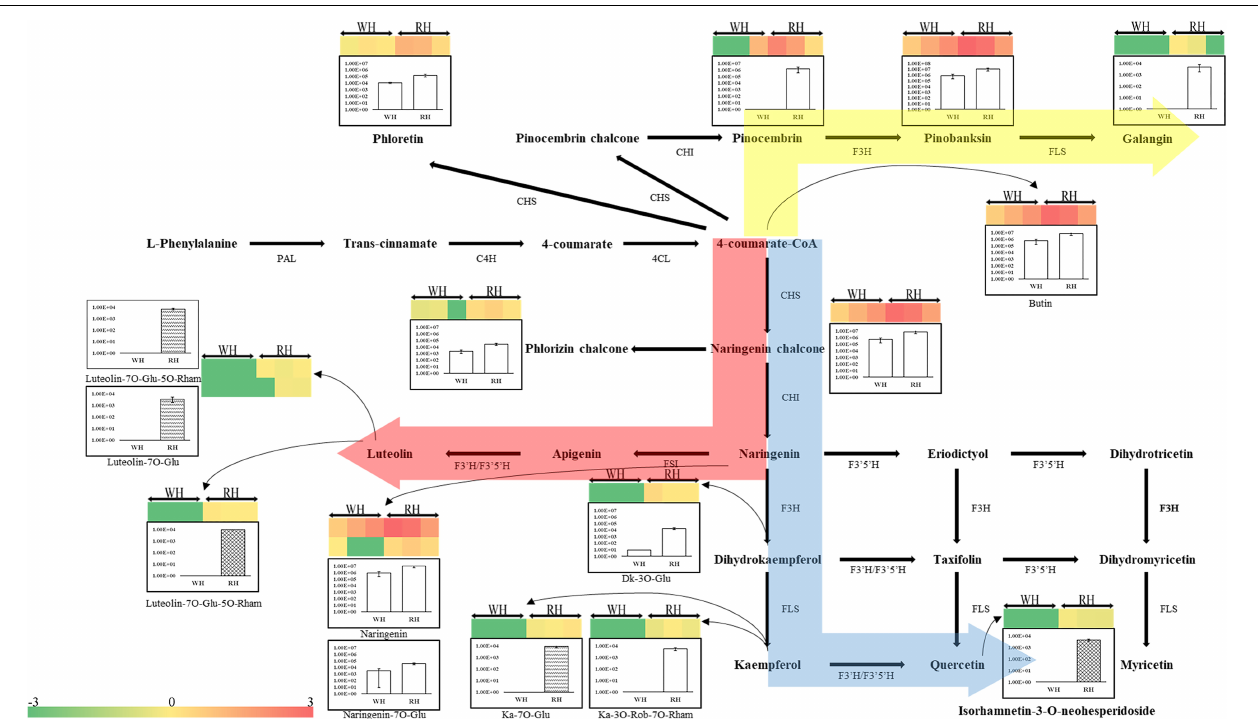
FIGURE 4 | Biosynthetic pathway of flavonoids. This pathway is constructed based on the Kyoto Encyclopedia of Genes and Genomes (KEGG) pathway and literary references. WH, white-heart Chinese fir; RH, red-heart Chinese fir; DK, dihydrokaempferol; Ka, kaempferol; Glu, glucoside; Rham, rhamnose; Rob, robinoside; PAL, phenylalanine ammonia-lyase; C4H, cinnamate 4-hydroxylase; 4CL, 4-coumarate CoA ligase; CHS, chalcone synthase; CHI, chalcone isomerase; F3H, flavanone 3-hydroxylase; FLS, Flavonol synthase; F3 (cid:48) H, flavanone 3 (cid:48) -hydroxylase; F3 (cid:48) 5 (cid:48) H, flavanone 3 (cid:48) -5 (cid:48) -hydroxylase. Each colored cell represents the normalized intensity of each compound ion according to the color scale (three biological replicates × two cultivars, n = 6). Column plots are shown for changes of flavonoids and their glycosylations in white-heart and red-heart Chinese fir. The empty column represents the WH-TZ vs. RH-TZ; the wave column represents the WH-OHW vs. RH-OHW; and the reticulate column represents the WH-ISW vs. RH-ISW.